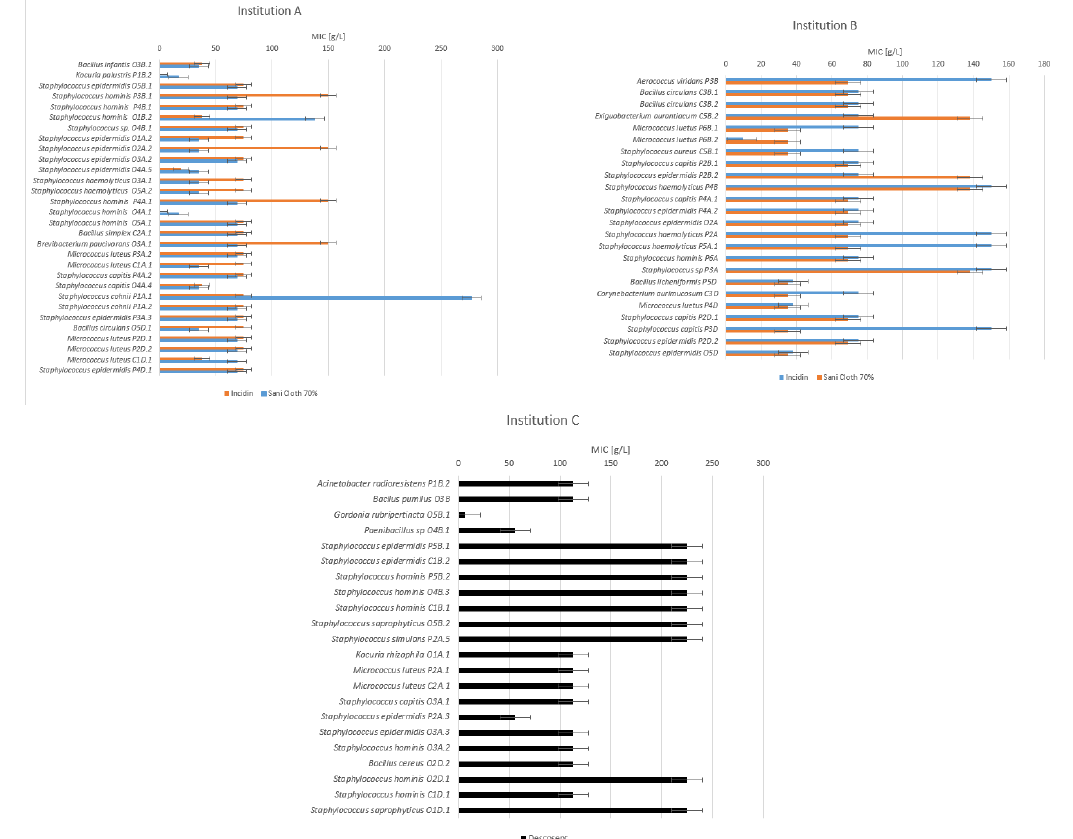
Figure 3. MIC values [g/L] for alcohol-based disinfectants Incidin, Sani-Cloth 70%, and Descosept for isolates in institutions (A), (B), and (C). Legend: P—physiotherapy; O—occupational therapy; C—common area; B—before use; A—after use; and D—after disinfection. The first number is the number of the sampled device (Supplementary Material File S1); the second number is the serial number of the isolate.